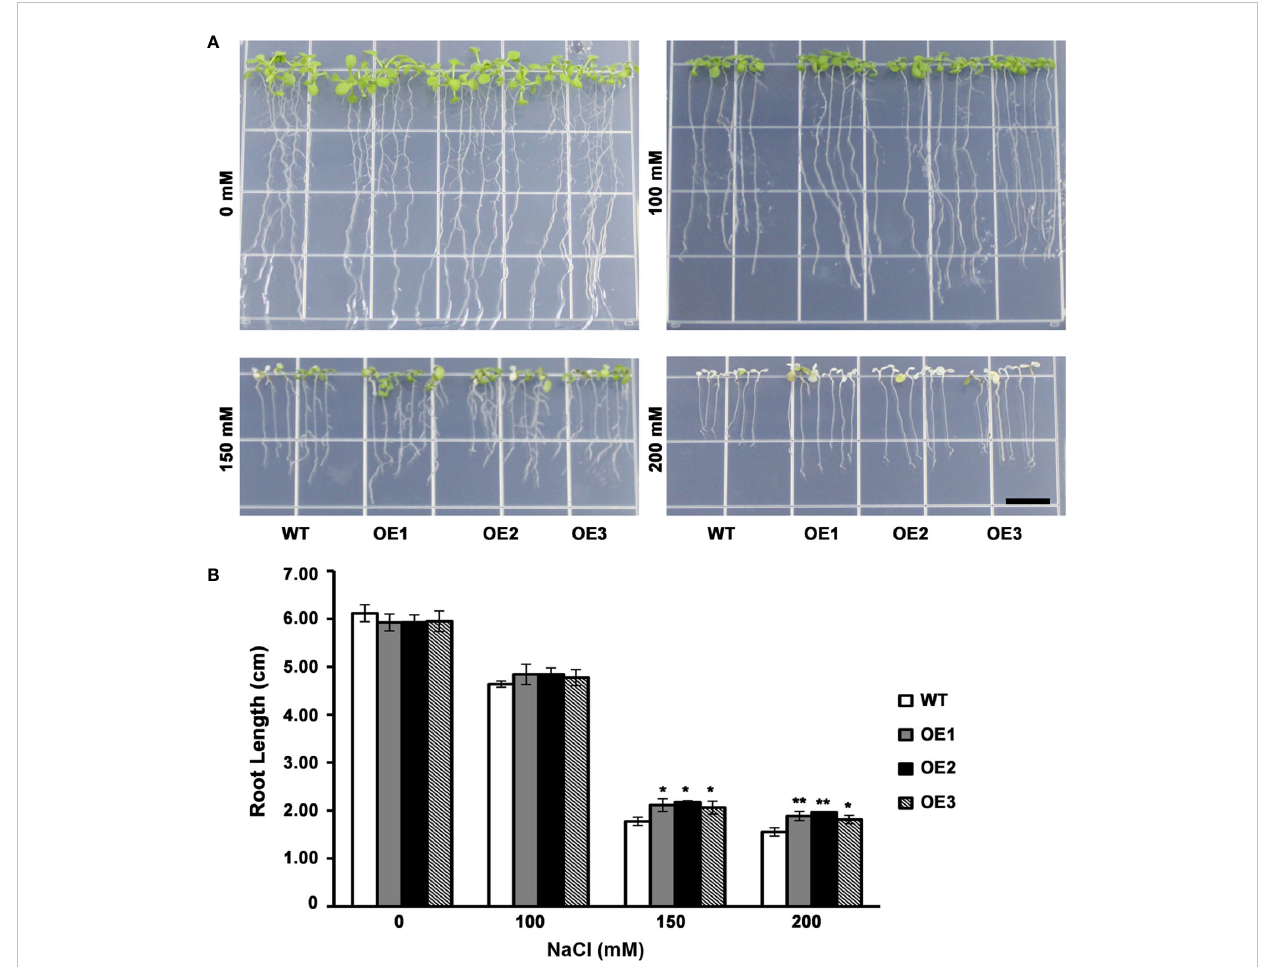
FIGURE 4 Effect of AhMYB30 expression on salt tolerance in transgenic Arabidopsis plants. (A) , Phenotype of WT and transgenic plants after salt stress. Wild- type and transgenic plants were germinated on ½MS agar plates for 3 d, then transferred to a new ½MS agar plate supplemented with different concentrations of NaCl for 5d; (B) , Root length of transgenic and WT seedlings treated with NaCl. All assays were repeated at least three times. Error bars represent SD of results of three replicated experiments. Scale bar for root length is 1 cm. Asterisks indicate a signi fi cant difference from the wild type (WT): *, 0.01<P<0.05 ( t -test); **, P<0.01 ( t